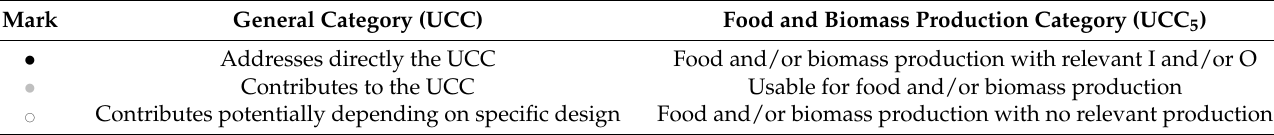
Table 1. Marking system for urban circularity challenges (UCC) addressed by nature-based solutions units (NBS_u), interventions (NBS_i), and supporting units (S_u), following Langergraber et al. [6,7] and categorization used for food and biomass production (UCC 5 ).